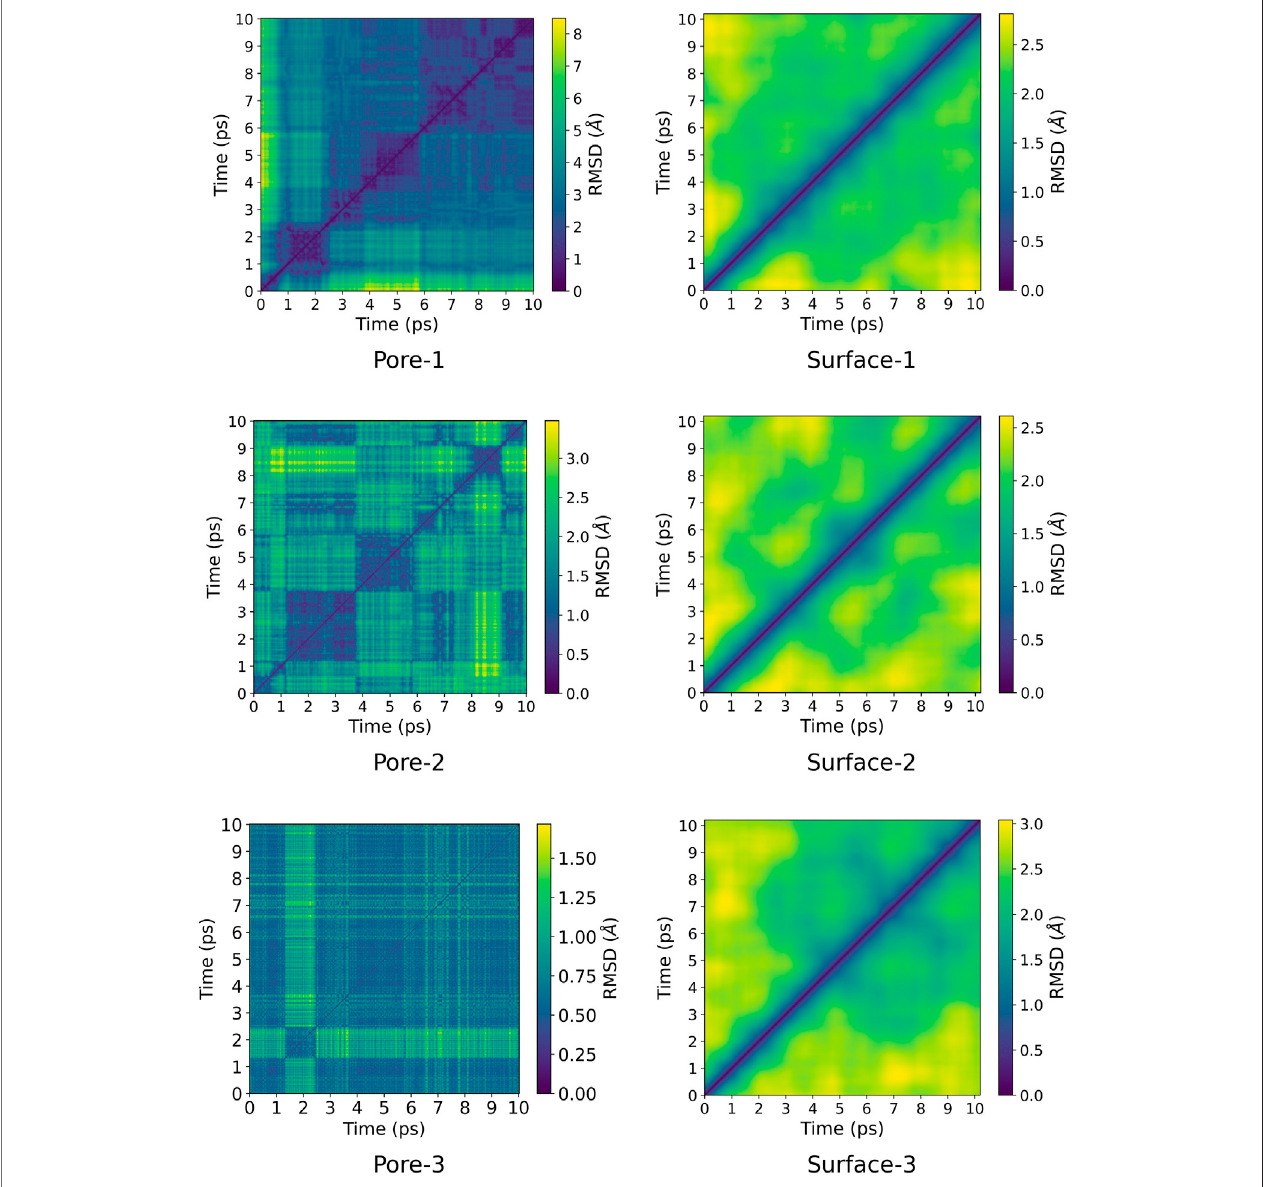
FIGURE3| PairwiseRMSDplotforZnPW I styreneinteractionsforbothnano-channelandsurfaceinteraction.ThecolourgradientcorrespondstotheRMSDinÅ. The labels ” Pore ” and ” Surface ” correspond to nano-channel and surface interactions respectively and the numbers after the hyphen correspond to the number of monomer(s)